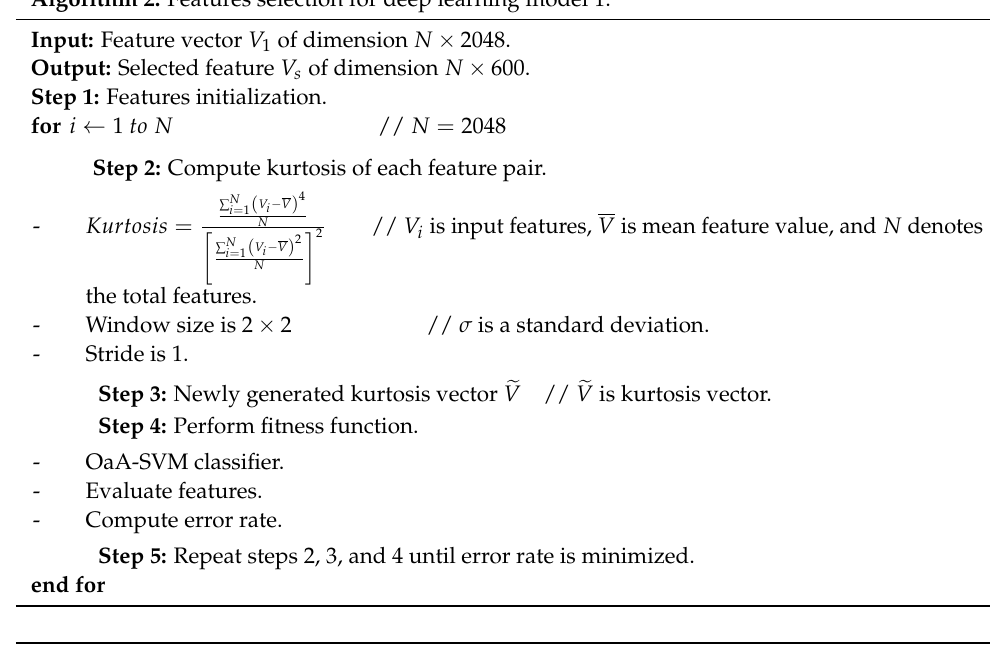
Algorithm 3: Features selection for deep learning model